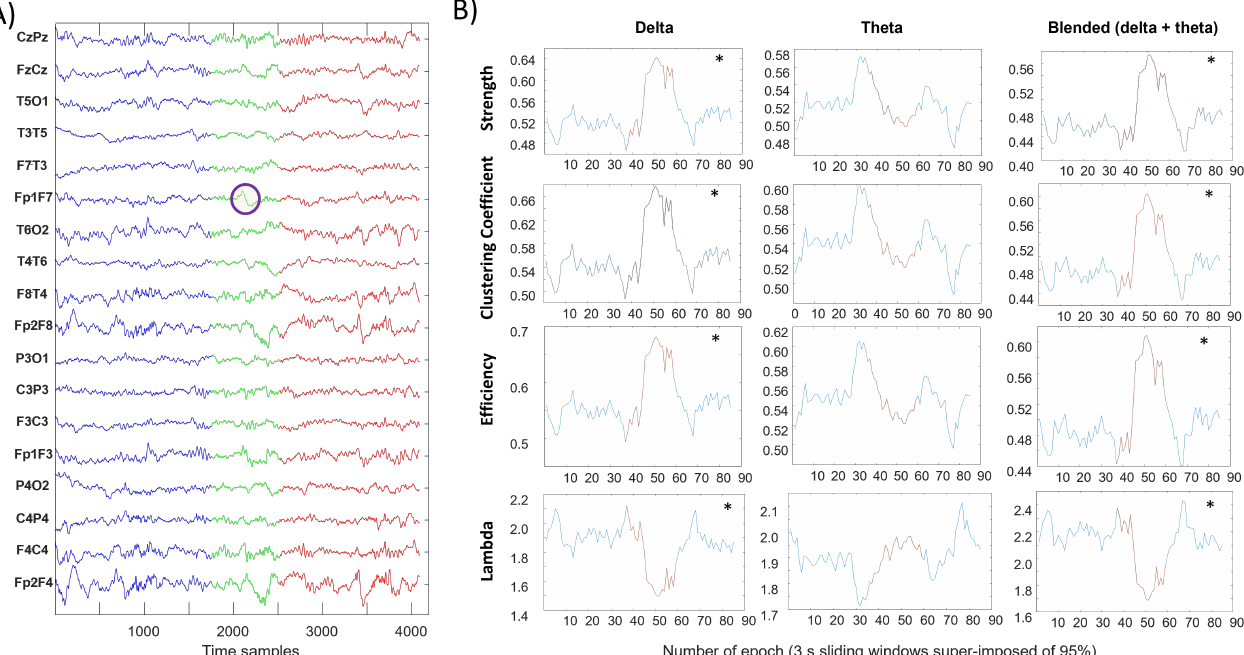
Figure 1. Evaluation of four topological indexes in three different frequency ranges for each sliding window of 3 s with a 95% overlap. ( A ) Signal before the SBC in blue, During–SBC in green (with the identified SBC circled in purple) and after the SBC in red. Blue and red signals can be considered as Far–SBC. ( B ) Trend of four topological indexes computed in each sliding window; the asterisk represents a significant difference (Wilcoxon rank sum test, p -value < 0.05) between the distributions of values computed in Far–SBC and During–SBC conditions (indicated in blue and red color,